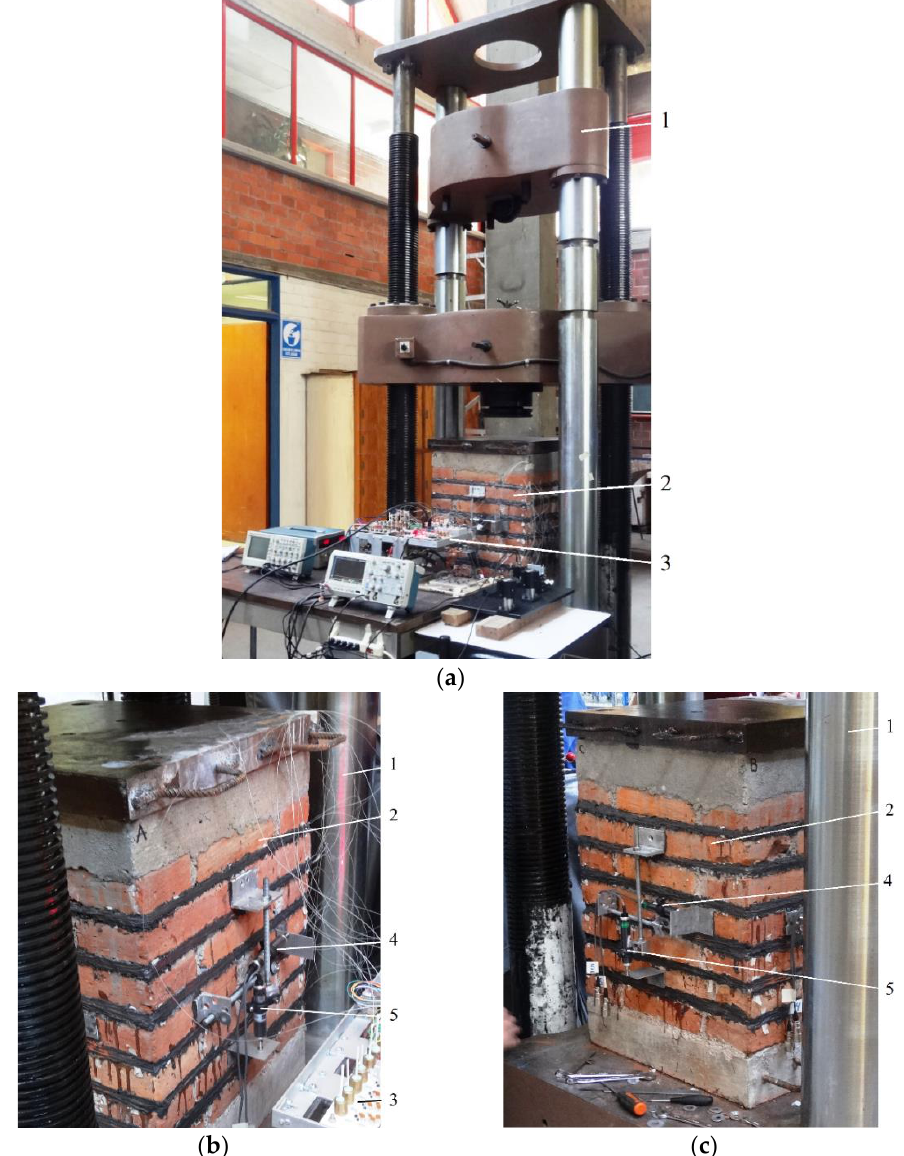
Figure 4. Brick masonry specimen: ( a ) instrumented with the optical fibers and LVDTs and installed in the test frame of the load machine; ( b ) the specimen front face (A); ( c ) the specimen back face (C). (1) Universal load machine; (2) brick masonry specimen; (3) opto-electronic monitoring system; (4) horizontal LVDT; (5) vertical LVDT.